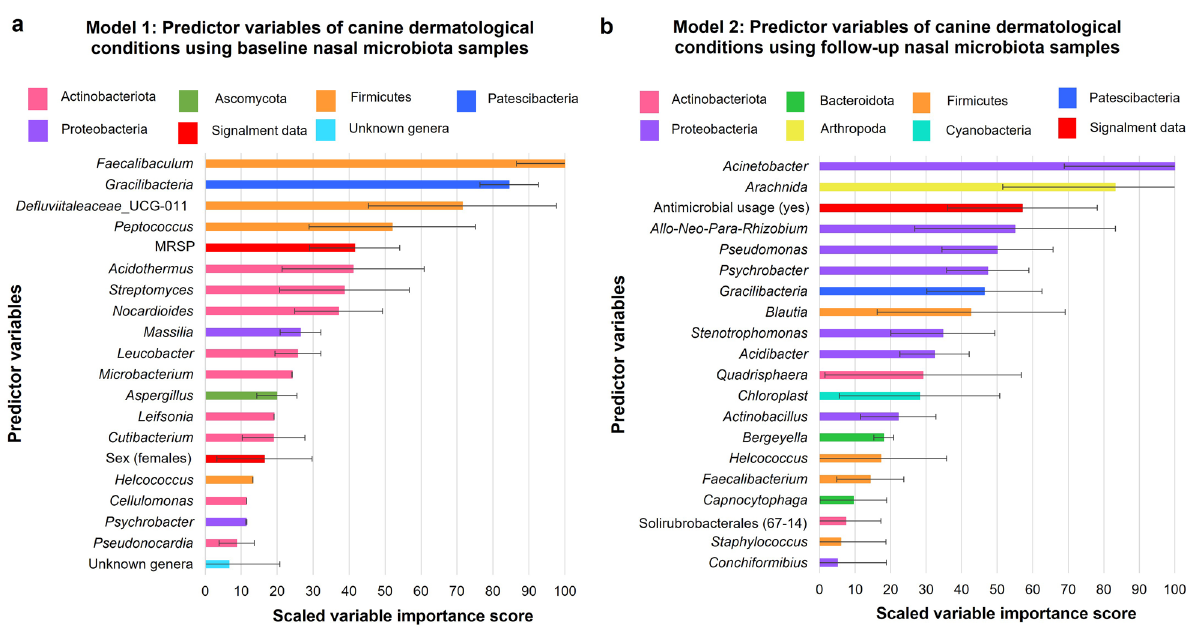
Figure 3. Barplots representing the top 20 most predictive variables identified by the elastic net logistic regression model for dogs with dermatological conditions. (a) Model 1 used only the baseline nasal samples and signalment data; and (b) Model 2 used only the follow-up nasal samples and signalment data. The whiskers (error bars) represent the standard deviations from training the selected features (variables) from the highest AUC models which were repeated 10 times (AUC ≥ 0.7). The coloured bars represent the different phyla. Allorhizobuim–Neorhizobium–Pararhizobium–Rhizobium was abbreviated to Allo-Neo-Para-Rhizobium in this graph. MRSP methicillin-resistant S. pseudintermedius